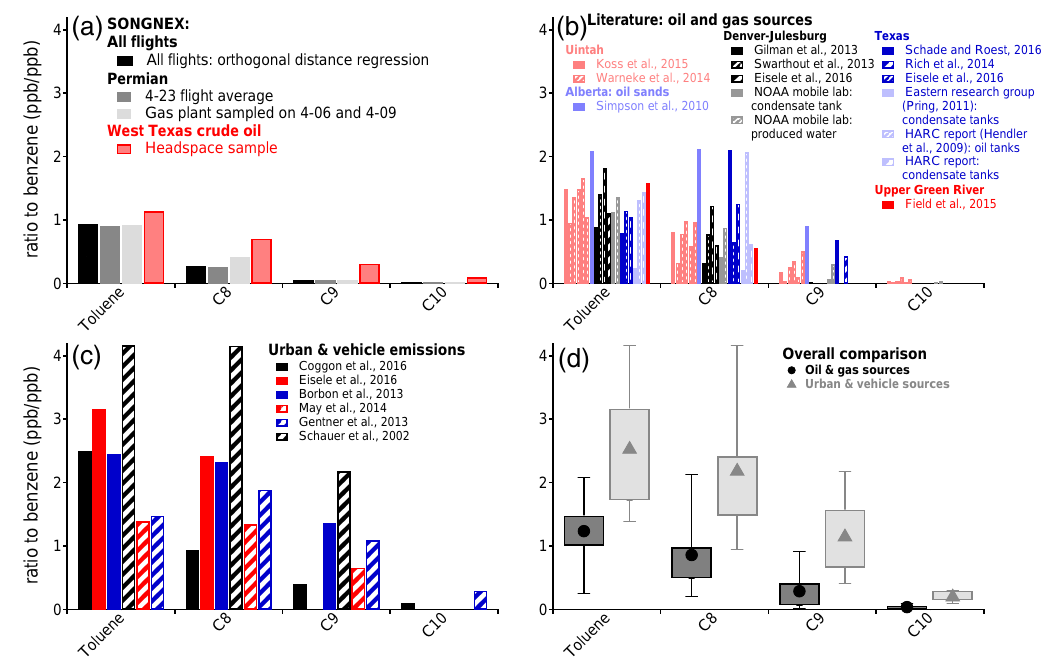
Figure 8. Comparison of C6–C10 aromatics distribution. Y axis (molar ratio to benzene) is the same in each panel. (a) Measurements by H 3 O + ToF-CIMS: SONGNEX flights and west Texas crude oil headspace. (b) Aromatic profiles from published studies of oil and gas fields, condensate tanks, oil tanks, and water storage tanks. (c) Aromatics profiles from published studies of urban areas and vehicle exhaust. (d) Average profiles of all oil and gas sources ( a and b ) and urban sources (c) .